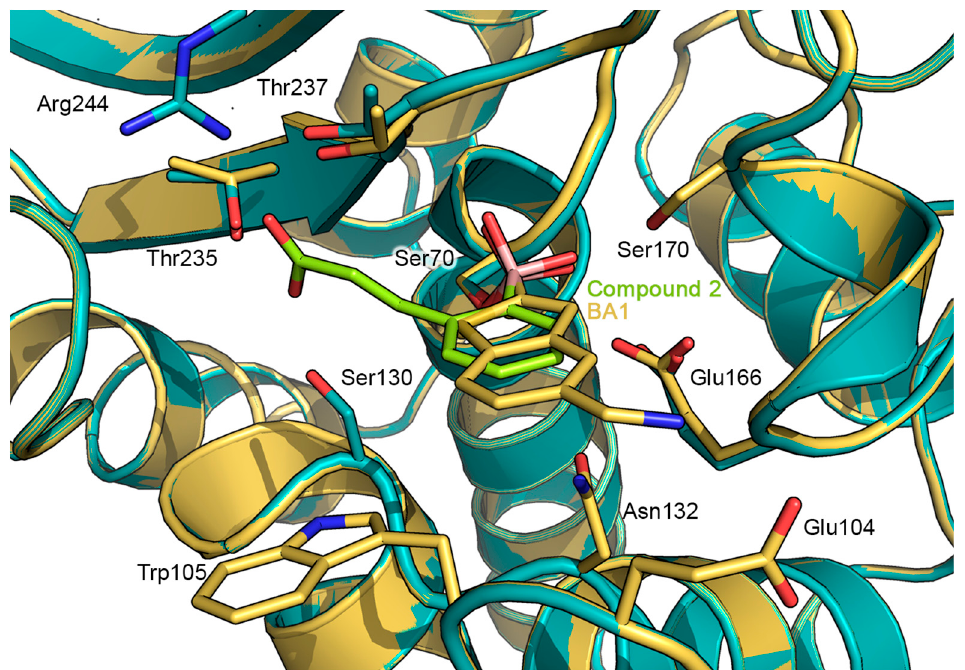
Figure 3. Superimposition of the predicted docking pose of compound 2 (green sticks) in complex with GES-5 protein (PDB ID: 6Q35, deep teal cartoon), with the X-ray structure of benzothiophene-2-boronic acid ( BA1 ) (yellow/orange sticks) in complex with GES-5 (PDB ID: 6Q35, pale yellow cartoon) [21]. Important amino acidic residues are shown as sticks, by using the color code adopted for the respective proteins. Heteroatoms are color-coded (oxygen in red, nitrogen in blue, boron in